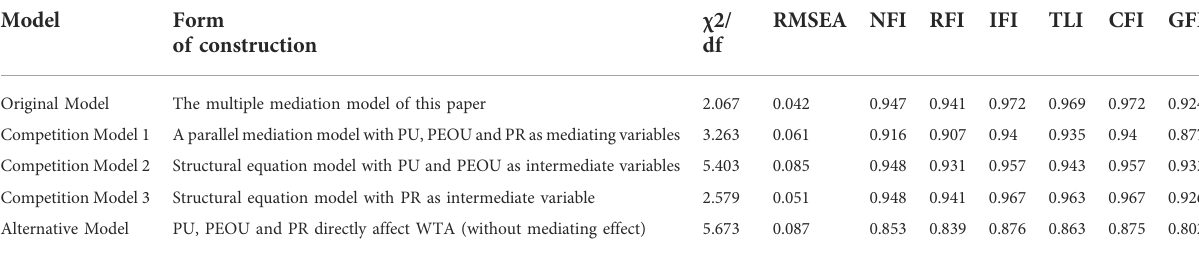
TABLE 6 Comparison of fi tting indexes of multiple models.